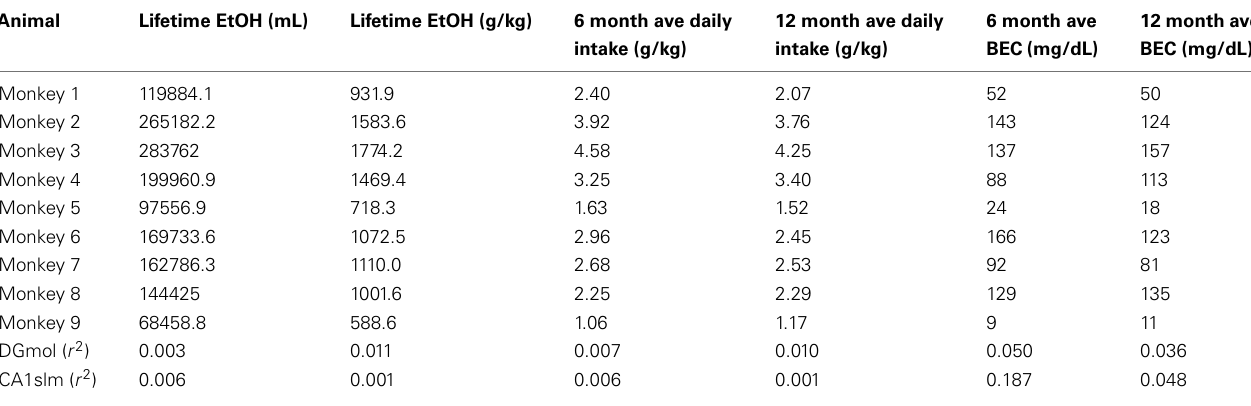
Table 1 | Correlation coefficients for hippocampal [ 3 H]citalopram binding and measures of ethanol consumption and blood ethanol concentration